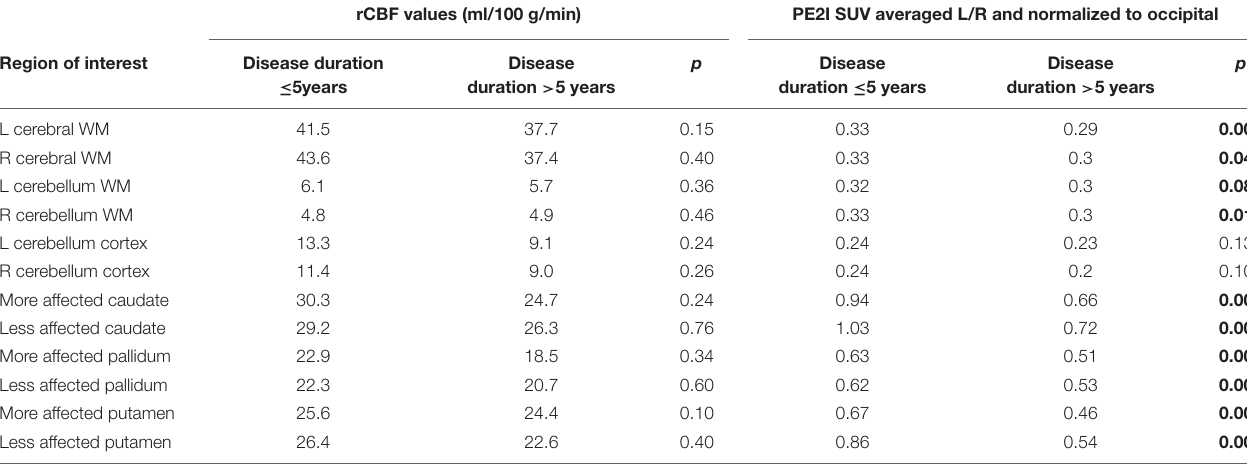
TABLE 2 | ASL rCBF and PE2I PET SUV values, stratified by disease duration. rCBF values (ml/100 g/min) PE2I SUV averaged L/R and normalized to